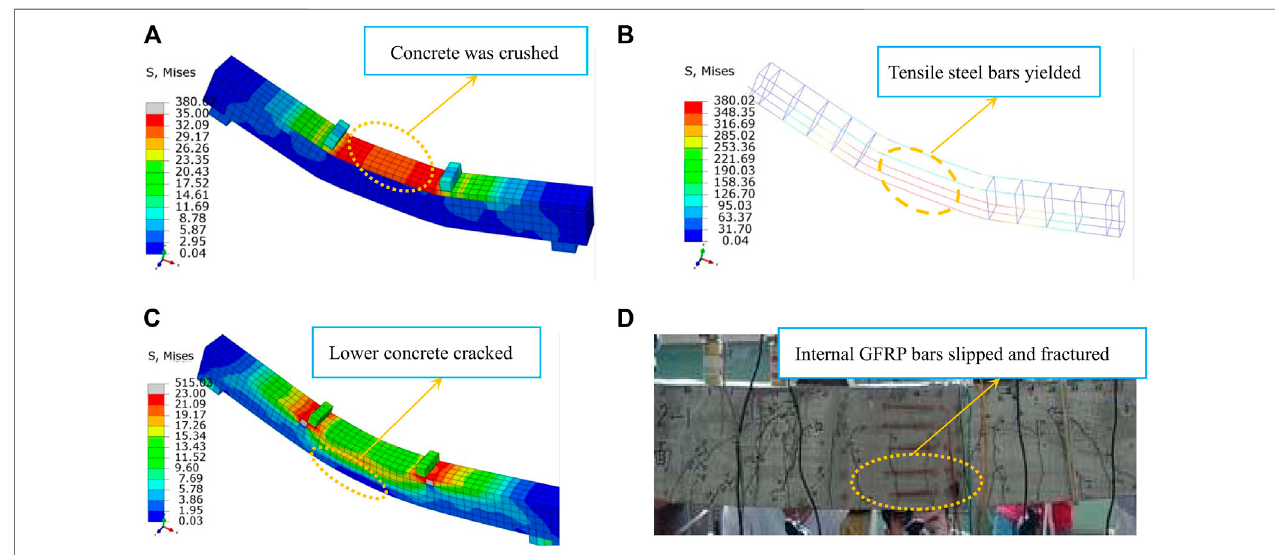
FIGURE 8 | Failure modes of B1 and BL2-1 specimens: (A) concrete of simply supported beam B1 was crushed; (B) tensile steel bars of simply supported beam B1 yielded; (C) lower concrete of simply supported beam BL2-1 cracked; (D) internal GFRP bars of simply supported beam BL2-1 slipped and fractured.